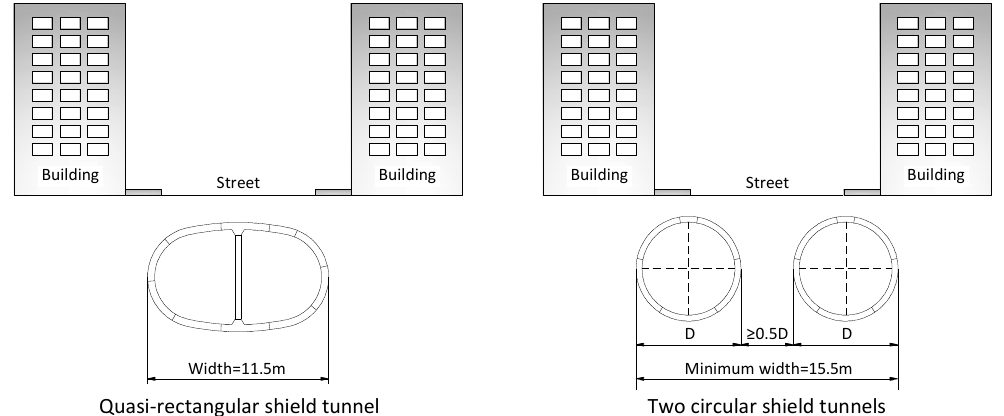
Figure 1. Comparison of two circular single track shield tunnels and a quasi-rectangular double track shield tunnel.